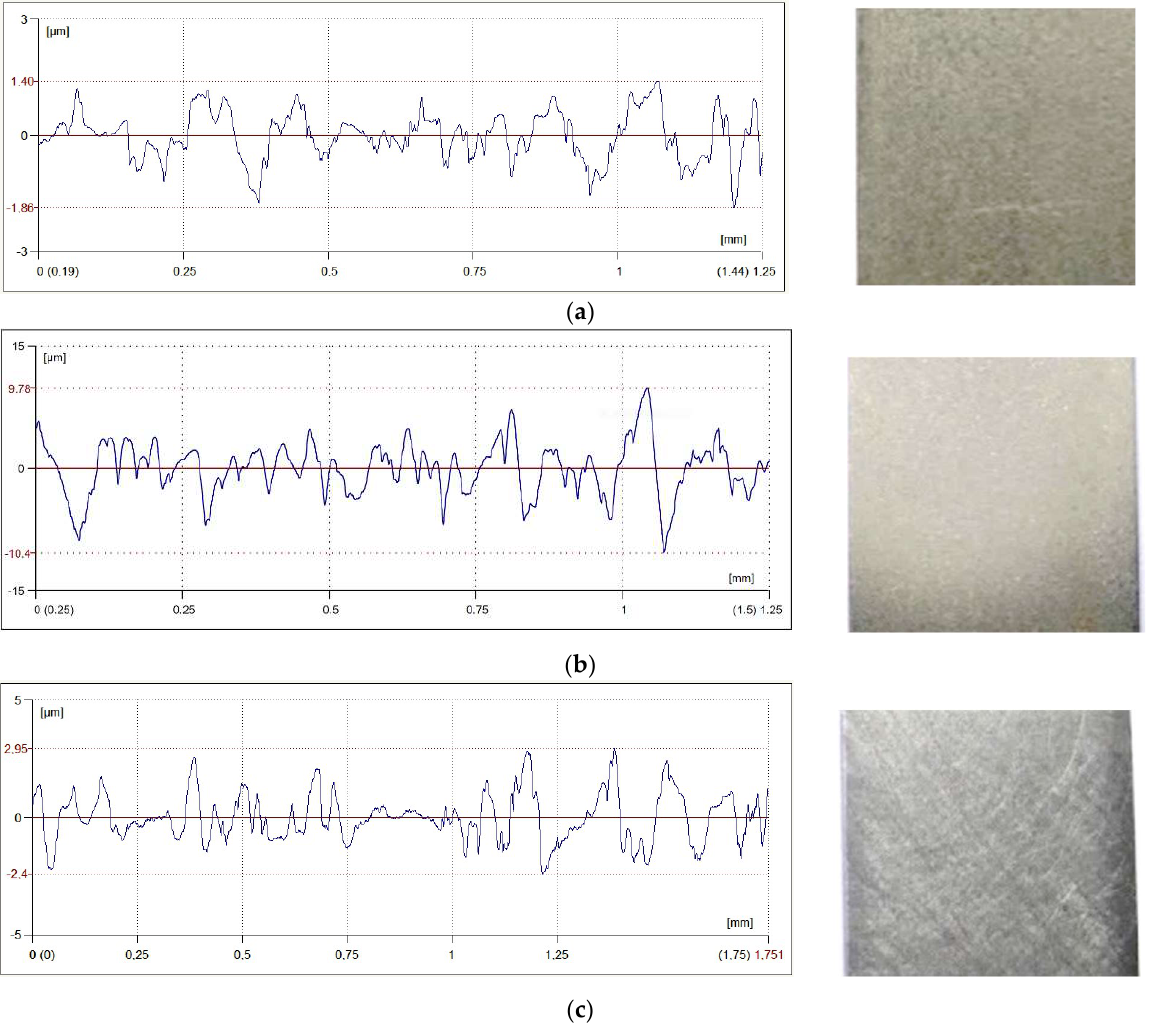
Figure 4. Roughness profile and view of the surface of the samples; ( a ) for the degreased surface, ( b ) for the abrasive blasted surface and ( c ) for the surface sanded with P80 paper.